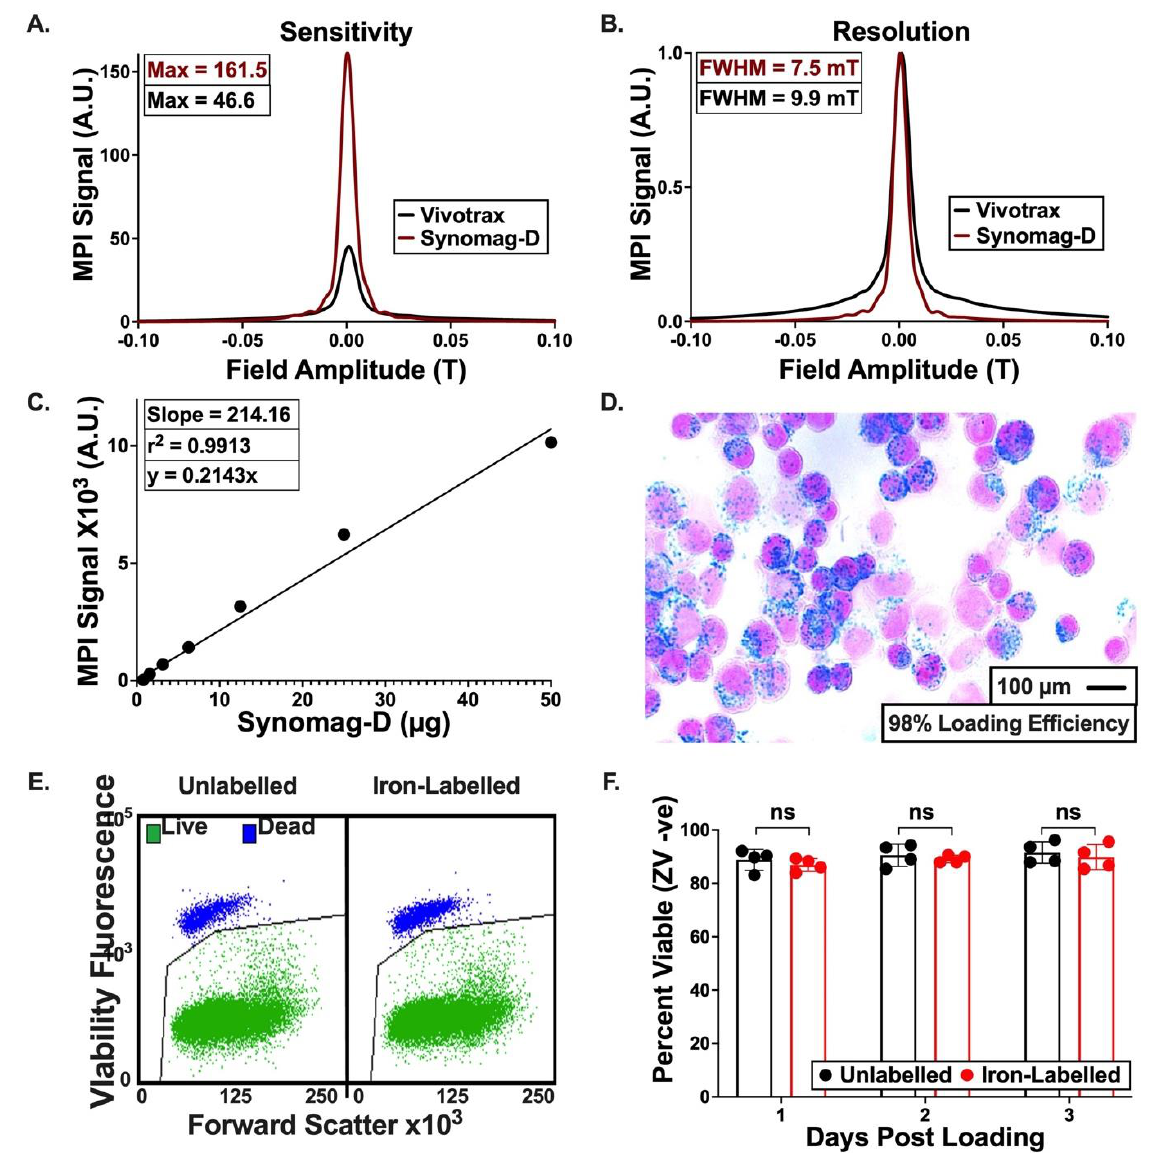
Figure 2. Characterization of Synomag-D. ( A ) Relaxometry curves for Synomag-D (red) and Vivotrax (black) show that Synomag-D produces 3.5 times more signal than Vivotrax, per iron mass. ( B ) Normalized relaxometry curves are used to assess signal resolution and show that the FWHM for Synomag-D is narrower than for Vivotrax. ( C ) The relationship between Synomag-D mass (ranging from 50 µg to 0.7 µg) and MPI signal produced shows a strong linear relationship. Iron content (μg) is equal to the total MPI signal (A.U.) divided by the slope of the calibration line. ( D ) Synomag-D loading of 4T1Br5-tdT-Akaluc cells was validated with Perl’s Prussian blue (PPB) stain and Nuclear Fast Red counterstain. Of these cells, 98% were PPB + . ( E , F ) Flow cytometry with the Zombie Violet viability assay shows no differences in the cell viability with Synomag-D labeling. ns: no significant.